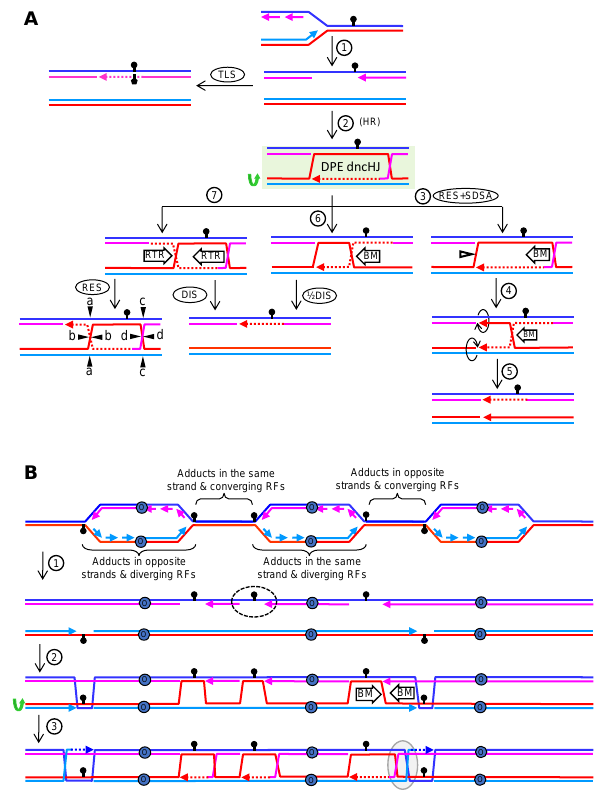
Figure 8. Bypass of replication blockage. ( A ) Gap repair during RS: (1), a DNA adduct (black bulb) blocks synthesis of the lagging strand during replication, leaving a ssDNA gap behind the RF; (2) the 3′ end melts and invades the sister chromatid, which acts as a donor to prime DNA synthesis and bypass the blockage, while the displaced strand is captured by the ssDNA gap, resulting in a DPE dncHJ; (3–5) the JM is processed by first resolving the nHJ with an SSE, followed by branch migration of the cHJ towards the opposing nicks (RES+SDSA-like); (6) alternatively, the cHJ could migrate towards the nHJ and both are eliminated through a half dissolution pathway (½ DIS); (7) the nHJ is ligated into a cHJ, and the resulting DPE dcHJ is processed as in Figure 7. The alternative non-HR translesion synthesis pathway (TLS) is also depicted. ( B ) DPO dcHJ can emerge through branch migration from two contiguous DPE dHJs. DNA adducts are expected to spread along a replicating DNA molecule. Several combinations regarding the relative position of adducts, direction of RFs and leading/lagging strand blockage are possible (indicated with brackets). (1) Replication termination would leave ssDNA gaps, even for leading strand blockage (dotted circle); (2) gap repair would proceed as in panel A to yield tandem dncHJs, which can be orientated as nHJ-cHJ-nHJ-cHJ (head-to- tail), cHJ-nHJ-nHJ-cHJ (head-to-head) or nHJ-cHJ-cHJ-nHJ (tail-to-tail); (3) Diverging branch migration can put in proximity two cHJ coming from different bypass events, resulting in DPO dcHJs when two adjacent dncHJs where in either head-to-head or tail-to-tail orientation (grey oval for an example coming from a tail-to-tail partner). An “O” within a dark blue circle points to replication origins. For other abbreviations and signs see previous figure legends.